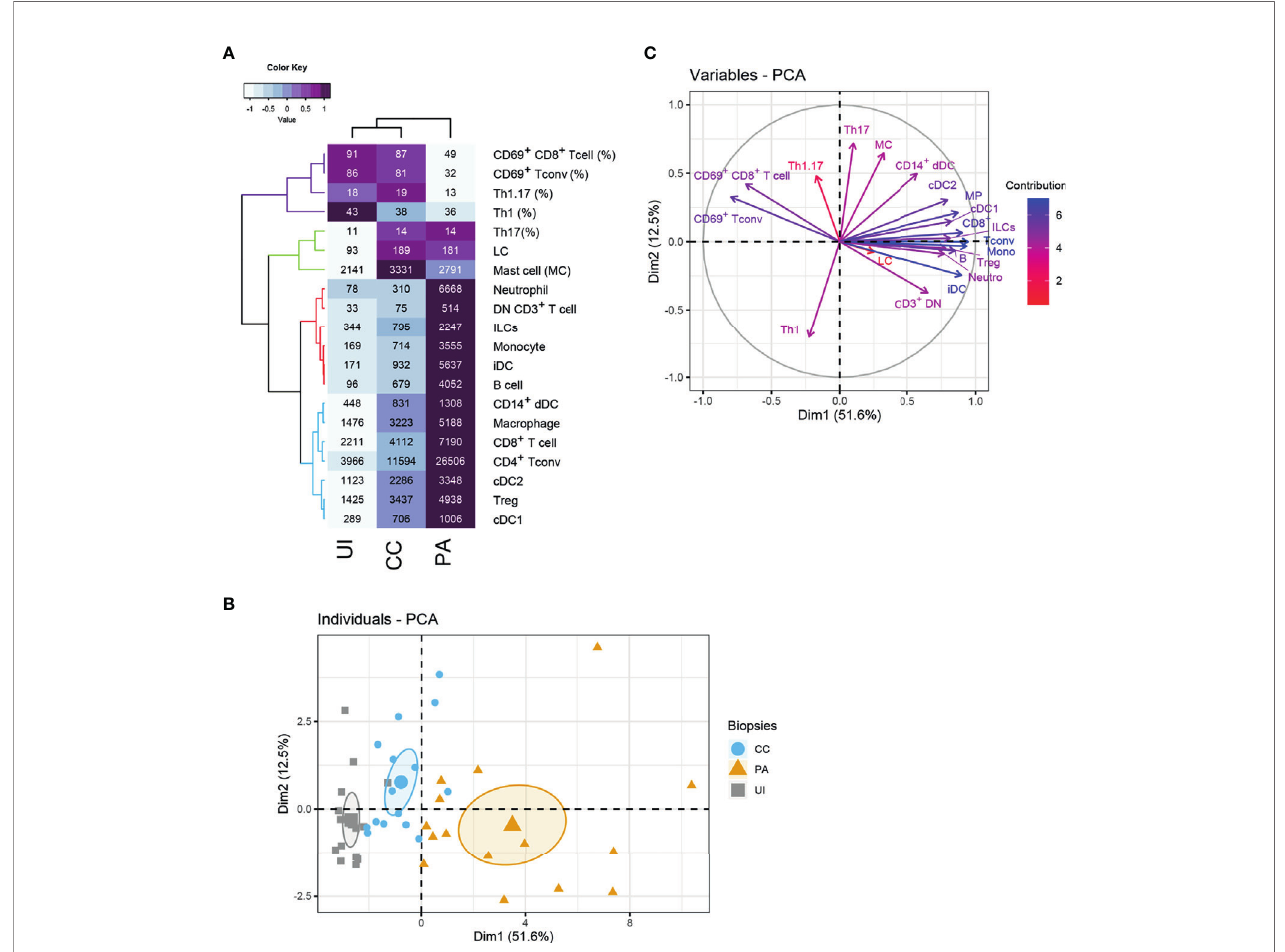
FIGURE 3 | Unsupervised analysis of the skin immune pro fi les of UI, CC and PA biopsies. (A) Heatmap depicting fl ow cytometry parameters calculated for UI, CC and PA biopsies (n=15 patients). The mean of each indicated fl ow cytometry parameter (showed in the cells) was scaled, centered, clustered hierarchically with complete linkage and Euclidean distance measure and visualized in the heatmap using the function heatmap.2 of the gplots R package. Principal component analysis (PCA) was performed with fl ow cytometry variables shown in the heatmap. (B) Individuals ’ PCA. Each dot represents one patient, color was attributed according to the acne stage. The bigger dot shows the group barycenter. The con fi dence interval of the mean (0.95%) is represented by ellipses. (C) PCA variable correlation plot. Variable contribution is shown by color code. Th1: CD161 - CXCR3 + T conv cells, Th17: CD161 + CXCR3 - T conv cells; Th1.17: CD161 + CXCR3 + T conv cells; CD3 + DN T cells: CD3 + CD4 - CD8 -